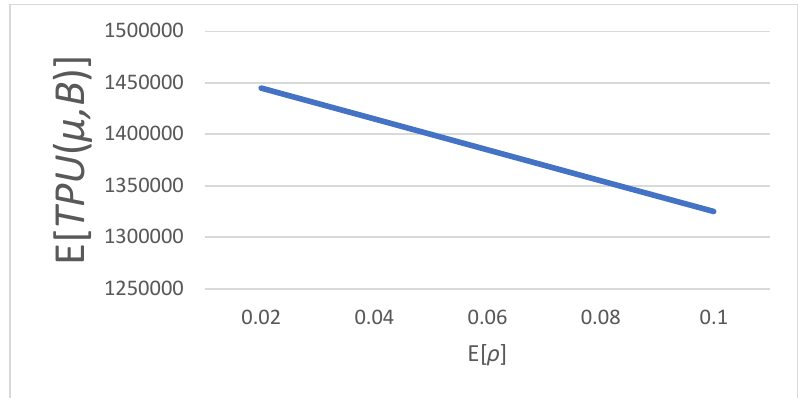
Figure 3. Effect of fraction of defective items ( 𝐸[𝜌] ) on optimal expected total profit